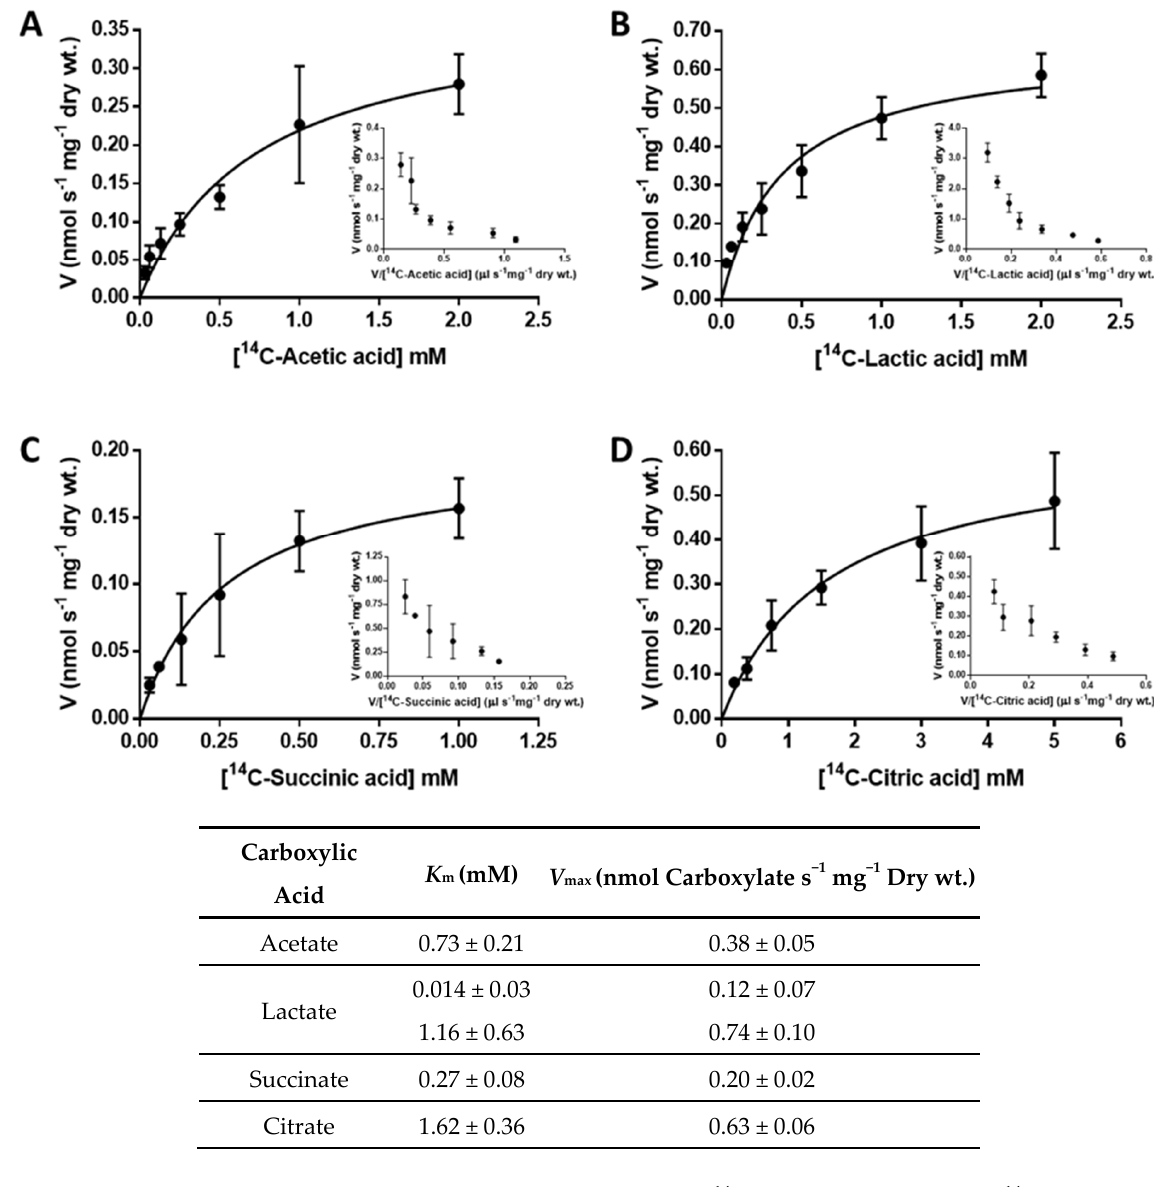
Figure 1. Initial uptake rates of labelled ( A ) 14 C − acetic acid, pH 6.0; ( B ) 14 C − lactic acid, pH 5.0; ( C ) 14 C − succinic acid, pH 5.0; and ( D ) 14 C − citric acid, pH 5.5, as a function of the acid concentration in C. jadinii DSM 2361 cells. The inserts represent the Eadie–Hofstee plots of the data presented in the respective main chart. The data shown are mean values of at least three independent experiments, and the error bars represent the standard deviation. The bottom-table presents the best fitting transport kinetic values for carboxylate transport systems in C. jadinii DSM 2361 cells, estimated with computer-assisted non-linear regression analysis.